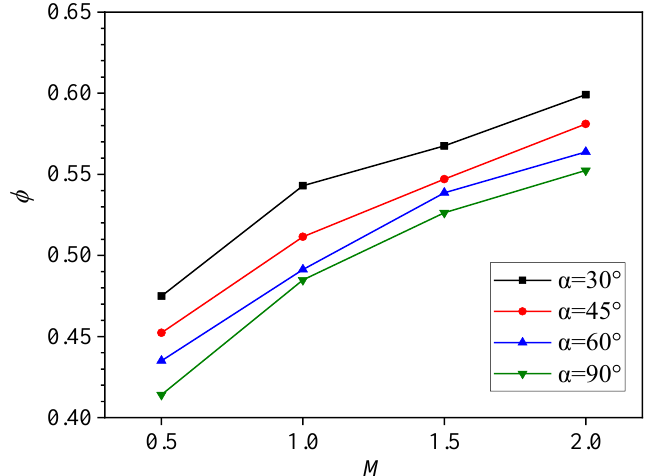
Figure 13. Area-averaged overall cooling effectiveness for cases with different values of α at each M .